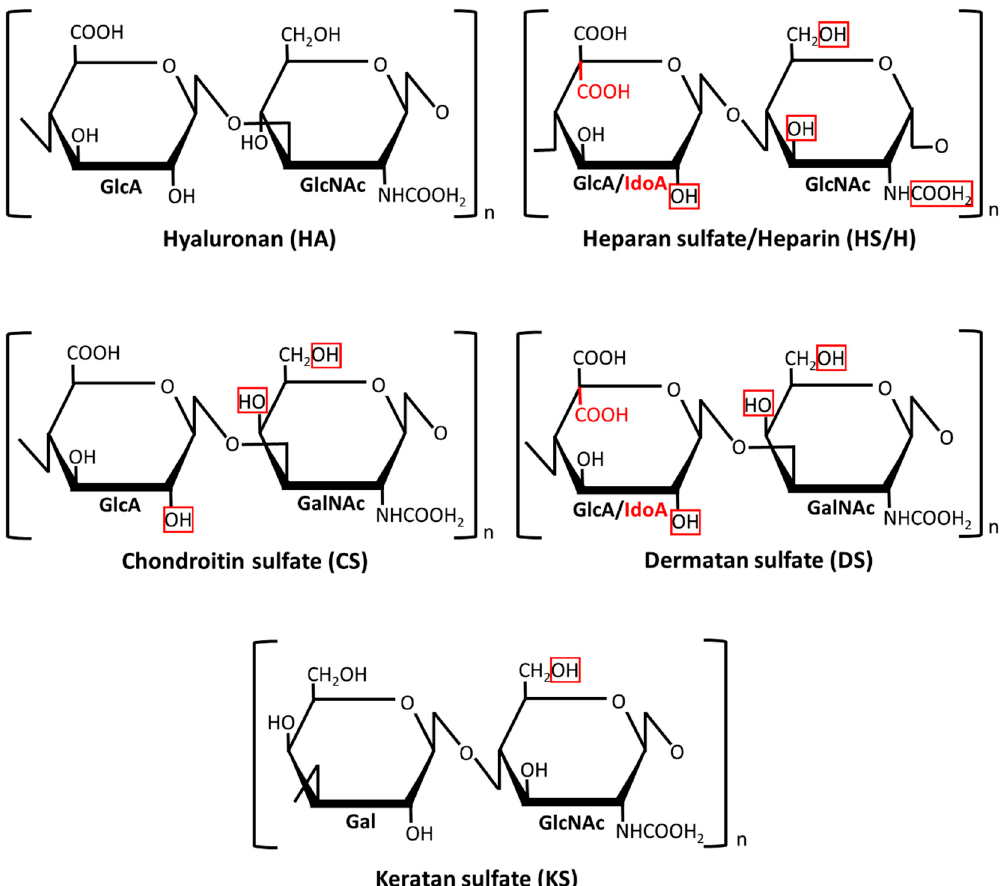
Figure 1. The structure of disaccharide units in the different types of glycosaminoglycans. Possible positions of sulfate groups are marked by encircling with a red line. n – polymerization degree; Gal – galactose; GalNAc – N-acetyl galactosamine; GlcA – glucoronate; GlcNAc – N-acetyl glucosamine; IdoA – iduronate.